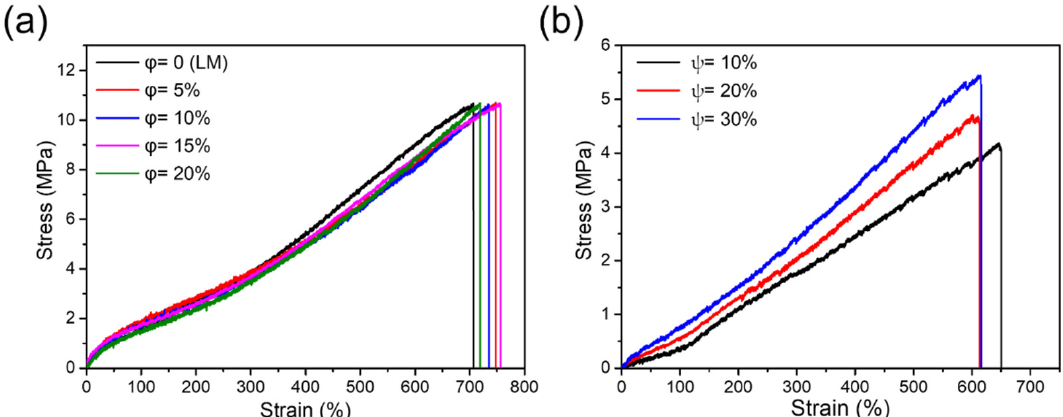
Figure 4. ( a ) Stress versus strain for the SEBS fibers with the MLM core as a function of iron particle concentration of 0, 5, 10, 15, and 20 wt% in the MLM wire ( φ ), ( b ) Stress versus strain for the hollow silicone (Exsil-100) composite fibers with MLM core as a function of iron particle concentration of 10, 20, and 30 wt% in the polymeric shell ( ψ ).